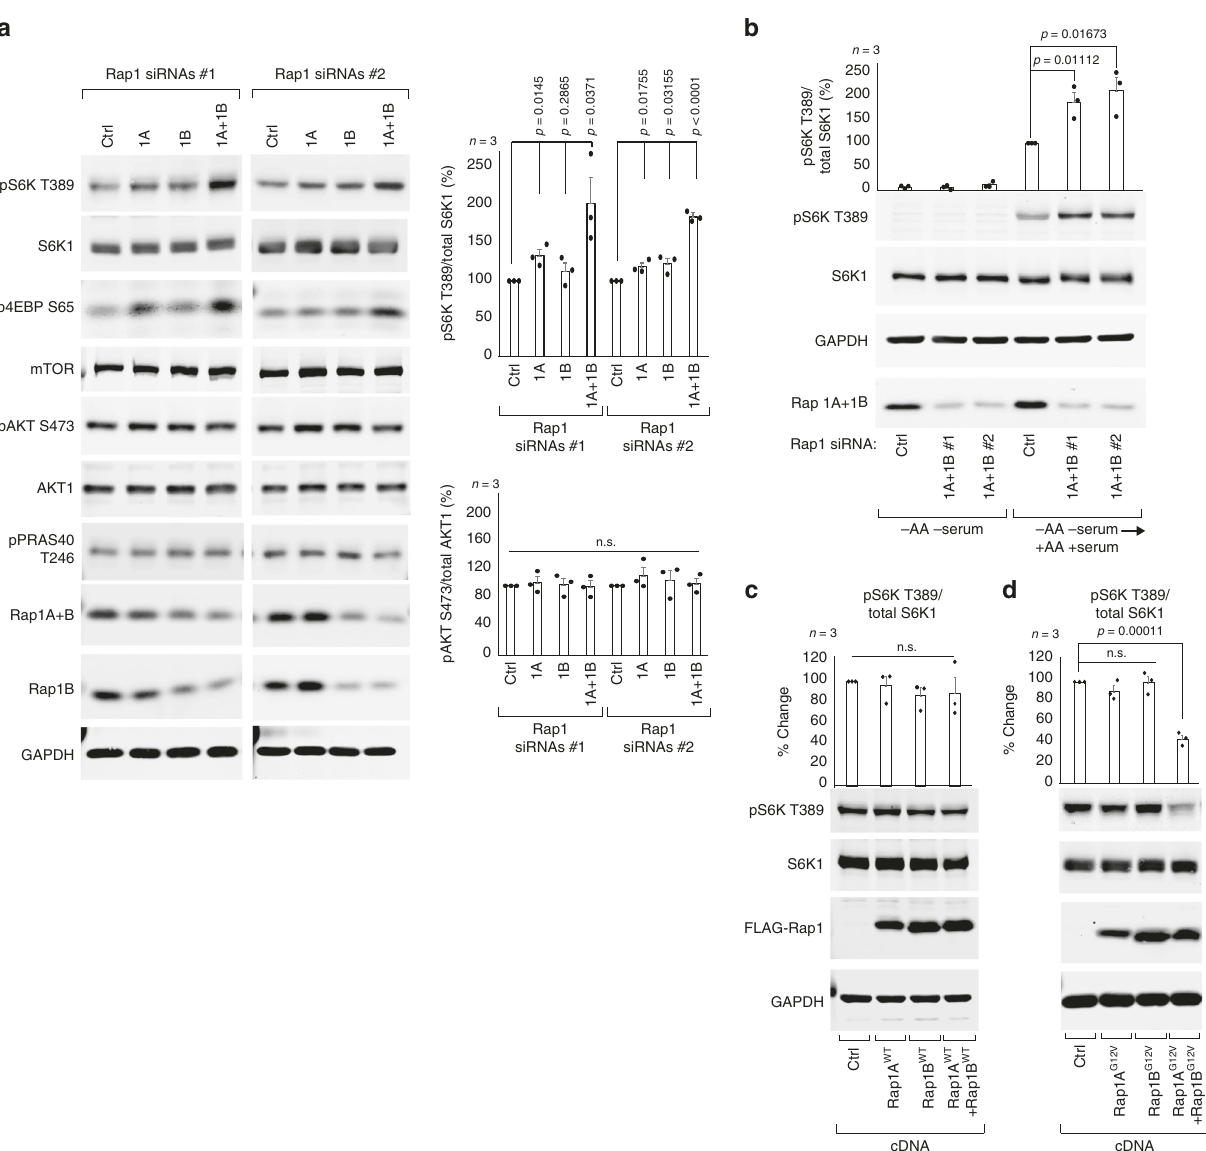
Fig. 1 Rap1 suppresses basal mTORC1 signaling. In a , b mTORC1 associated signaling was assessed in HEK293A cells after siRNA depletion of Rap1A, Rap1B or both Rap1A and Rap1B, by immunoblotting endogenous proteins, as indicated. Quanti fi cations are shown to the right and in Supplementary Fig. 1. In the bottom graph, p = 0.888 and p = 0.724 for pAKT S473 siRNA Ctrl vs Rap1A + B#1 and Ctrl vs. Rap1A + B #2, respectively. In b cells were depleted of serum and amino acids for 60 min and stimulated with full growth media for 10 min. In c , d HEK293T cells were transfected with an equal amount of the indicated cDNA vectors and serum deprived before subjected to immunoblotting. Graphs represent relative immunoblot band intensity from three individual experiments ( n = 3). Statistical data are presented as mean values ± s.e.m. n.s. = not signi fi cant ( P > 0.05); Student ’ s t -test; two-sided, unpaired. pS6K T389 and total S6K1 were processed on separate blots due to technical reasons. In c p = 0.6730, 0.1417 and 0.1532 for EV vs Rap1AWT, Rap1BWT and Rap1A + BWT, respectively. In d p = 0.1798 and 0.9251 EV vs Rap1AG12V and Rap1BG12V, respectively. See Source Data File for statistics source data. Uncropped images of blots are shown in Supplementary Fig.